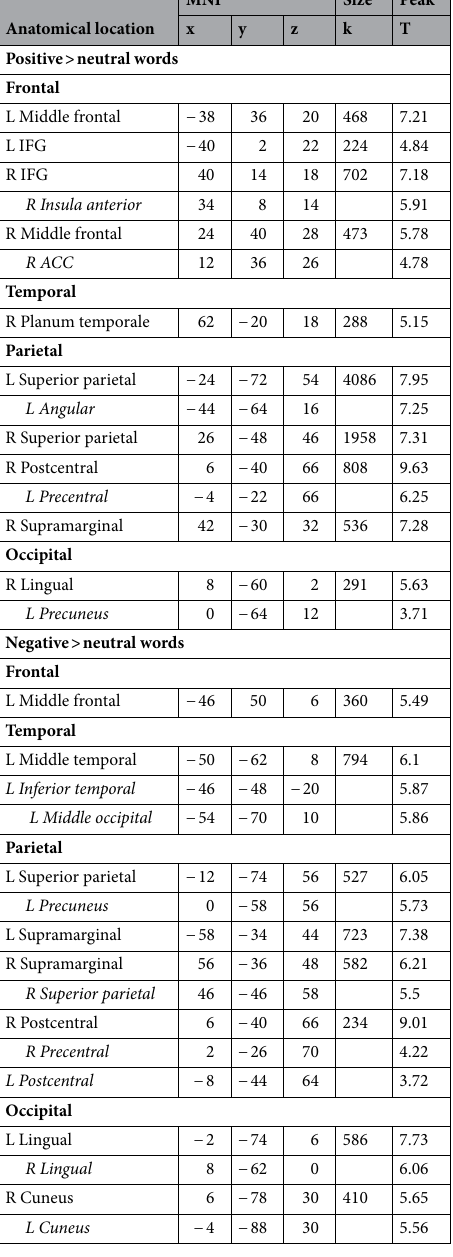
Table 4. Children’ activation for the contrasts positive words compared to neutral words and negative words compared to neutral words (FWE corrected, p < 0.05, cluster level). x, y, z peak coordinates according to MNI stereotactic space, k cluster size in voxels, T -values for peaks, R right, L left, ACC anterior cingulate